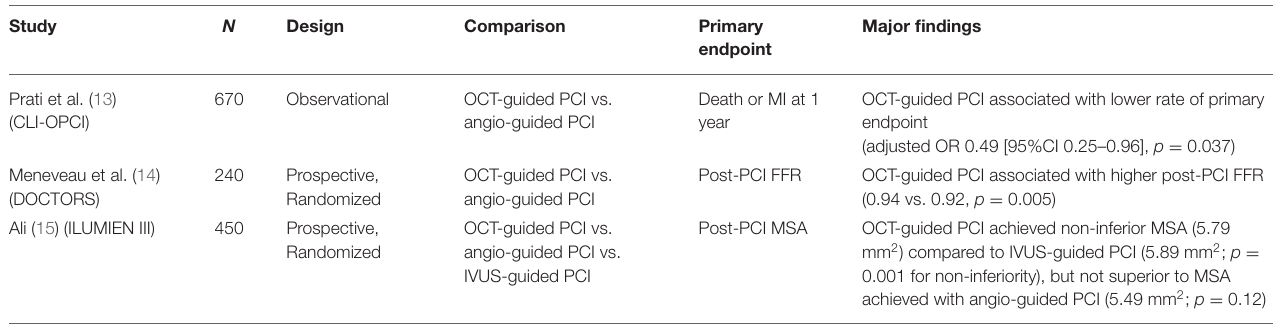
TABLE 1 | Summary of studies evaluating OCT-guided